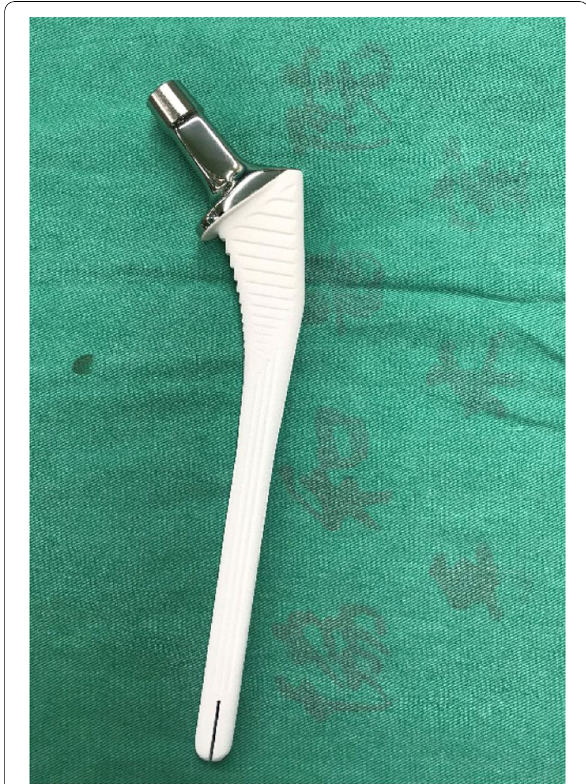
Fig. 1 The bone-conserving revision stem is a cementless, tapered titanium stem with a collar and extensive hydroxyapatite coating on the